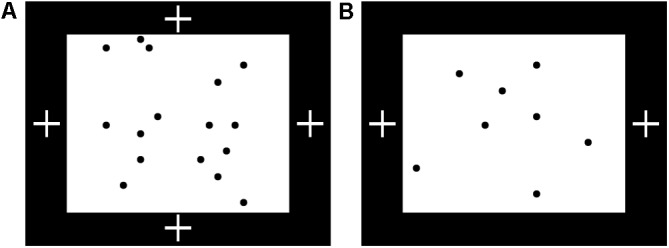
Familiarization setup for Experiment 3. (A) Possible positions of fixation video (white crosses) during familiarization with 16 dots in Experiment 3, with sample exemplar. The fixation video was shown at the top or bottom (bilateral condition) or left or right (unilateral-16 condition) of the screen, within a black border surrounding the images of 8 or 16 dots. (B) Position of fixation video during familiarization with eight dots, with sample exemplar.